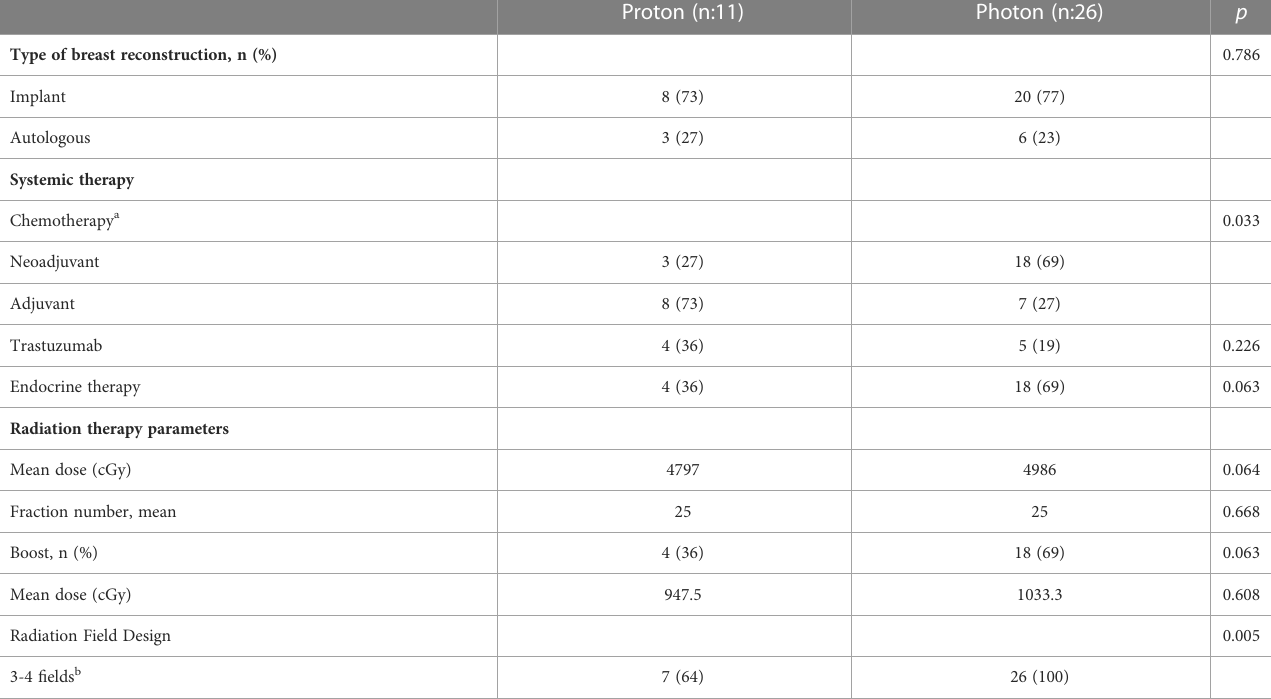
TABLE 2 Treatment ‐ related